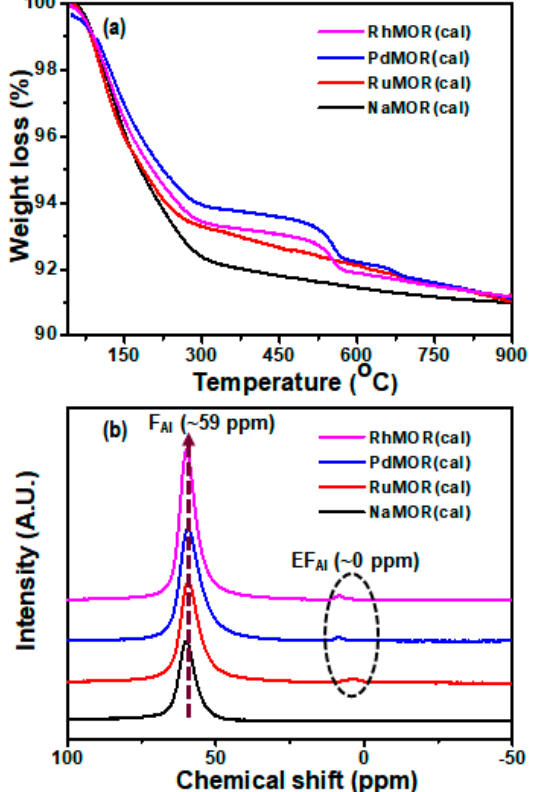
Figure 4. ( a ) Thermogravimetric analysis (TGA) data of NaMOR(cal), RuMOR(cal), PdMOR(cal), and RhMOR(cal), reflecting a total weight loss of ~9%. ( b ) Solid-state MAS 27 Al NMR spectra of NaMOR(cal), RuMOR(cal), PdMOR(cal), and RhMOR(cal). The strong peak at ~59 ppm is attributed to tetrahedrally coordinated framework aluminum atoms (F Al ). The low-intensity peak close to 0 ppm for RuMOR(cal), PdMOR(cal), and RhMOR(cal) correspond to the octahedrally coordinated extra-framework aluminum atoms (EF Al ).